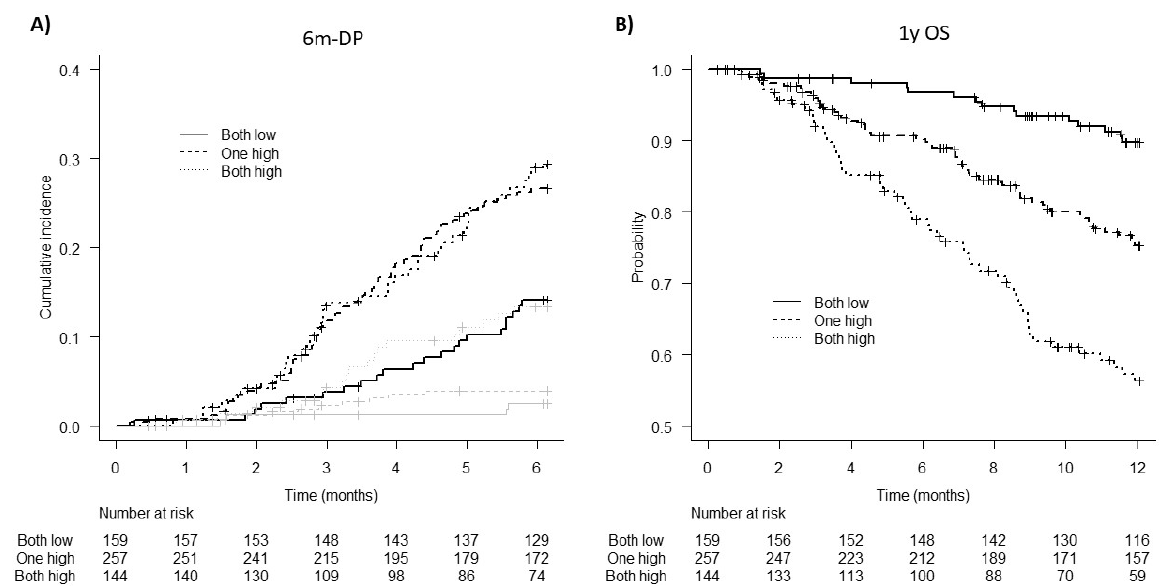
Figure 1. ( A ) Crude cumulative incidence of 6m-DP and ( B ) Kaplan–Meier estimates of 1-year OS according to risk groups based on D-dimer and TG ETP levels. Continuous line = low risk (both under threshold), dashed line = intermediate risk (at least one over threshold), and dotted line = high risk (both over threshold). Grey lines are corresponding estimates of the competing event. 6m-DP: 6-month disease progression, 1y OS: 1-year overall survival, TG: thrombin generation, ETP: endogenous thrombin potential.